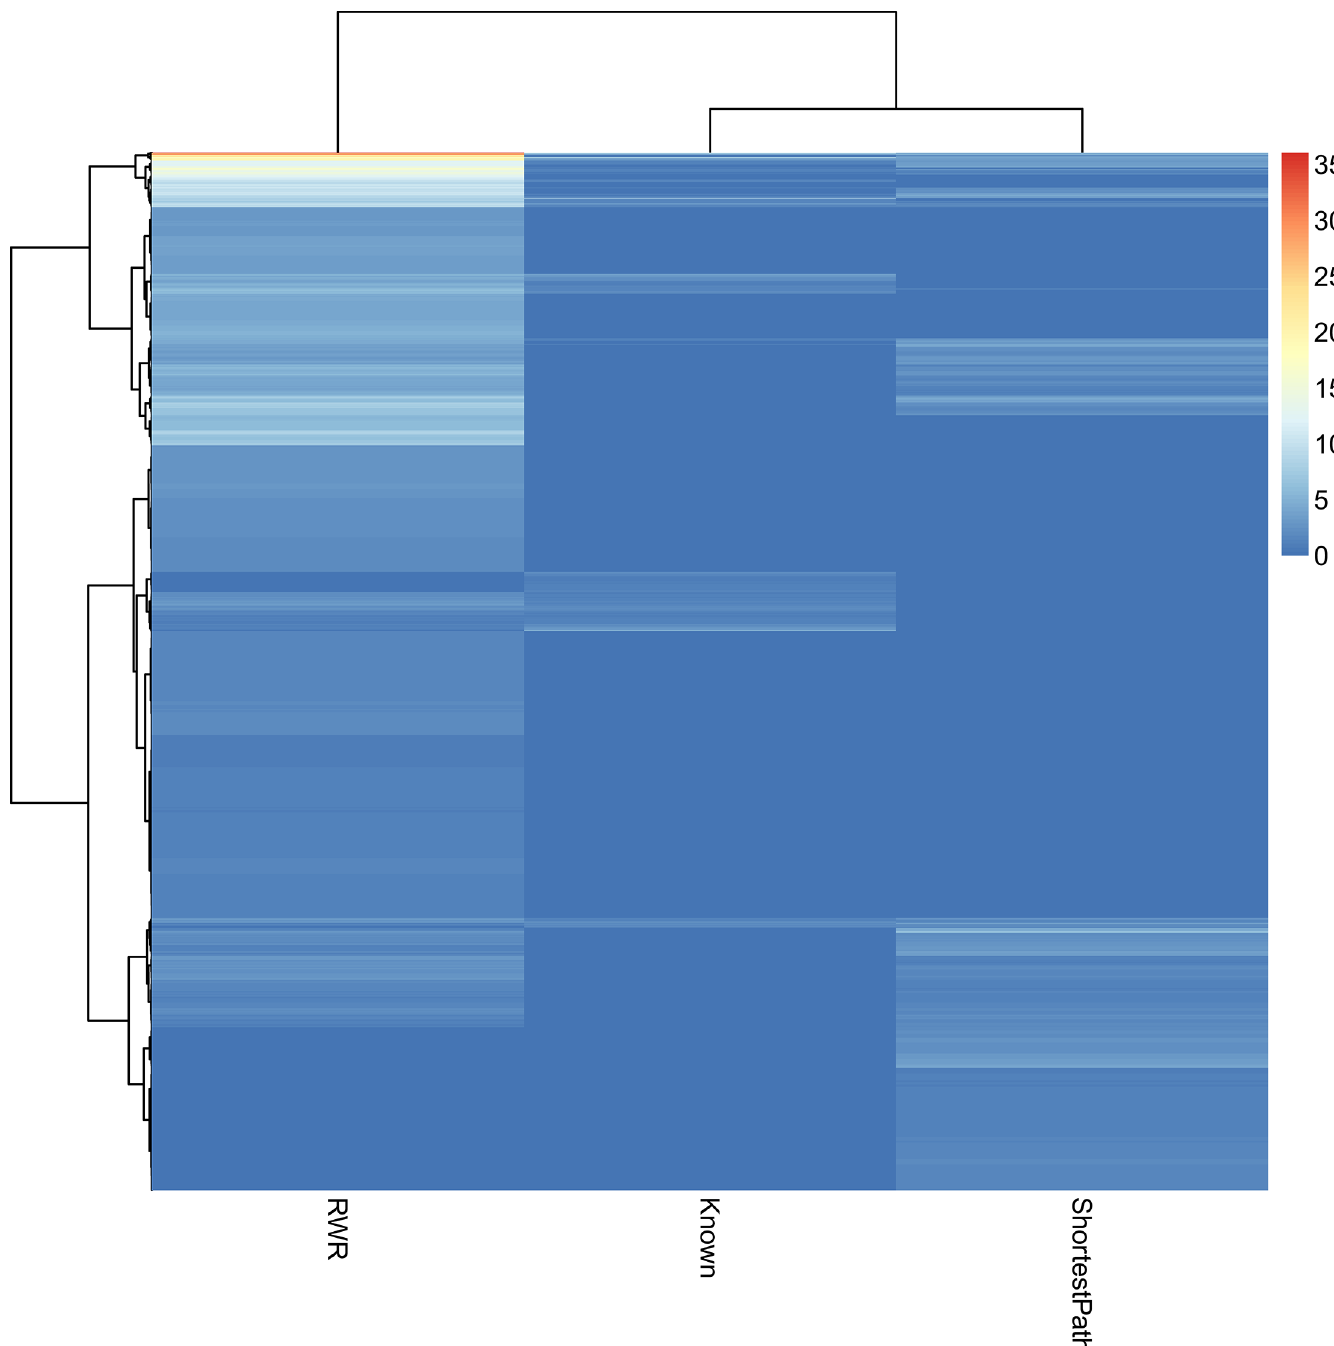
Fig 4. The heatmap of the functional profiles of three gene sets: known esophageal cancer related genes, shortest path predicted genes and RWR predicted genes. The color indicates the enrichment score, i . e .,-log10(enrichment p value). The shortest path predicted genes have more similar functions with the known esophageal cancer related genes as they are clustered